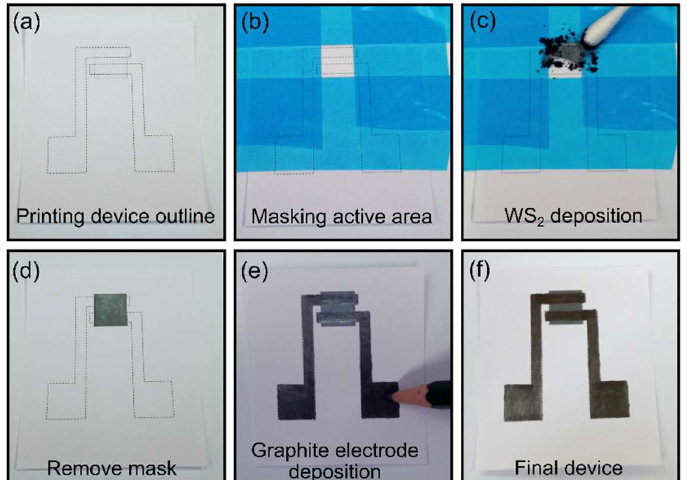
Figure 1. Process sequence for the sensor fabrication. ( a ) The outline of the device is printed with a standard office printer using standard copy paper. ( b ) Nitto SPV 224 tape is used to mask around the active area of the device. ( c ) An active film of WS 2 nanoplatelets is deposited by mechanical abrasion of micronized WS 2 powder against the paper surface. ( d ) The mask is removed, showing the patterned WS 2 film on paper active area of the device. ( e ) Graphite electrodes are patterned by simply filling in, with a 4B graphite pencil, the area between the device outline dotted lines. ( f ) Picture of the final fabricated device.